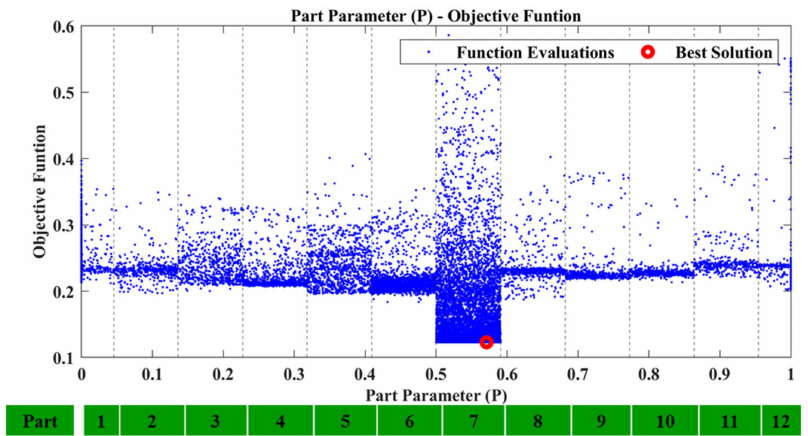
Figure 23. D7: Part parameter (P) versus the Objective Function